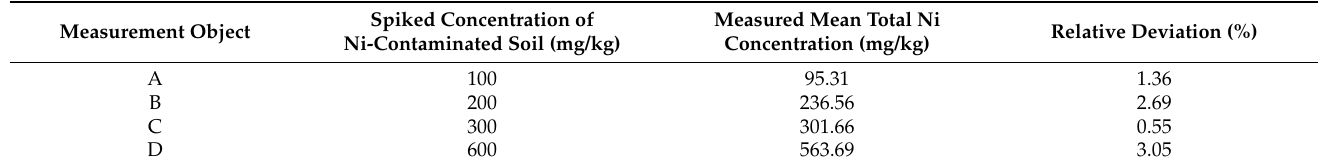
Table 2. Measured concentrations of total nickel (all fractions) in spiked remediation soil samples and the range of relative